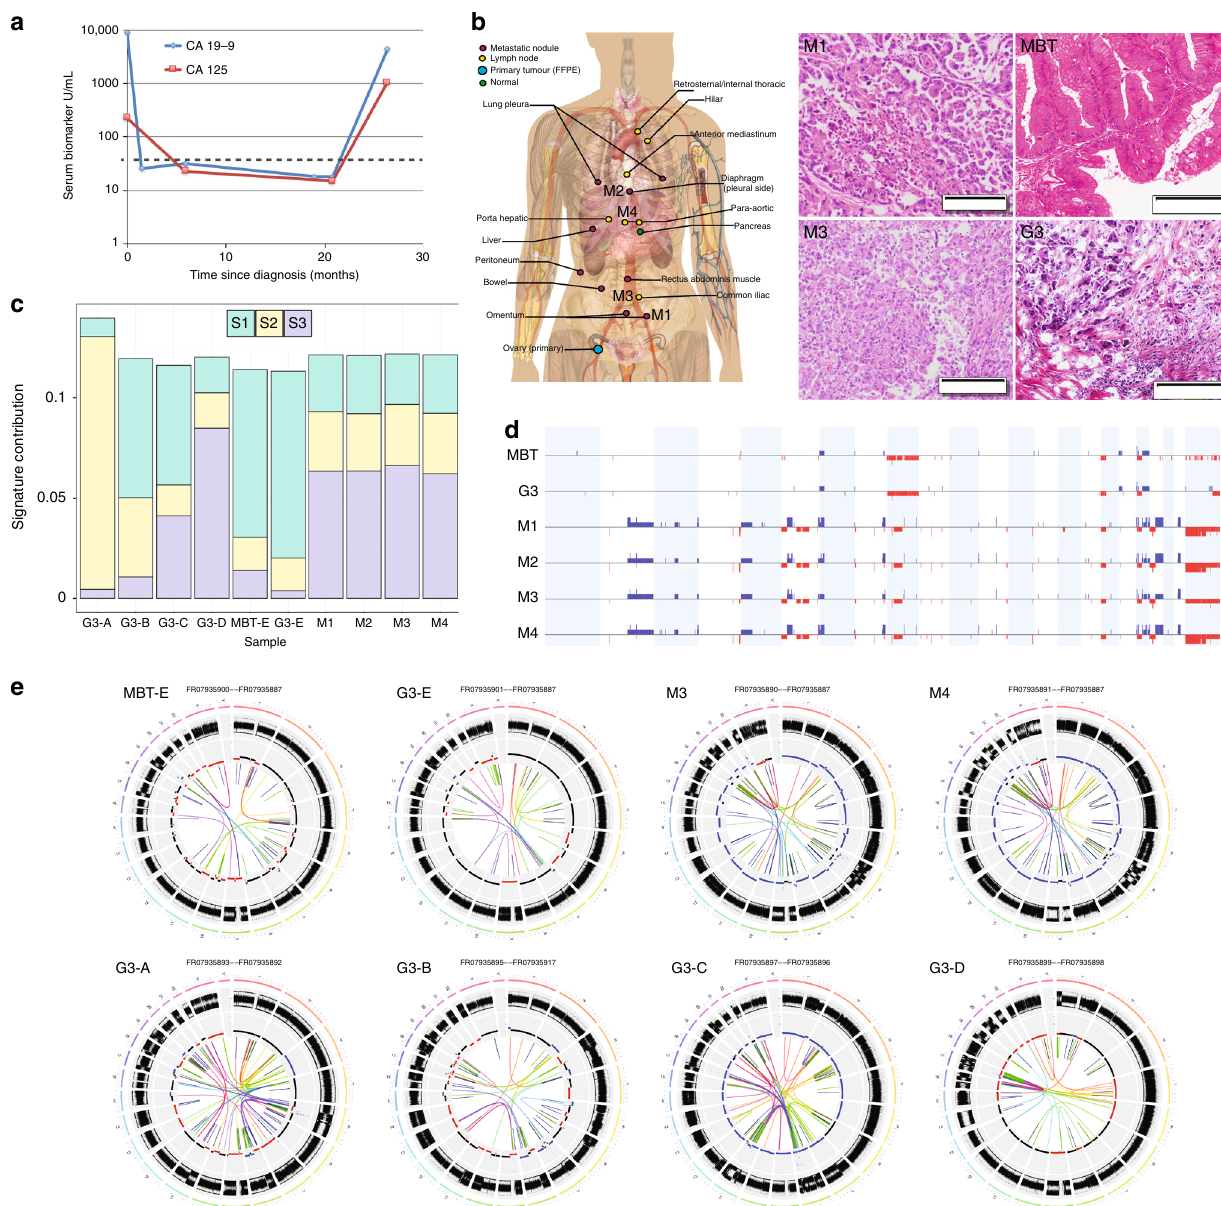
Fig. 4 Molecular evolution of Grade 3 MOC and metastatic disease. a Serum markers of rapid autopsy case. Dashed line indicates maximum normal level. b Schematic of location of metastatic tissues taken at autopsy and haematoxylin and eosin stained sections of metastatic sites (M1 and M3) as well as two areas of the primary tumor, the majority borderline morphology (MBT) and the small area of high-grade invasive tumor identi fi ed in the frozen